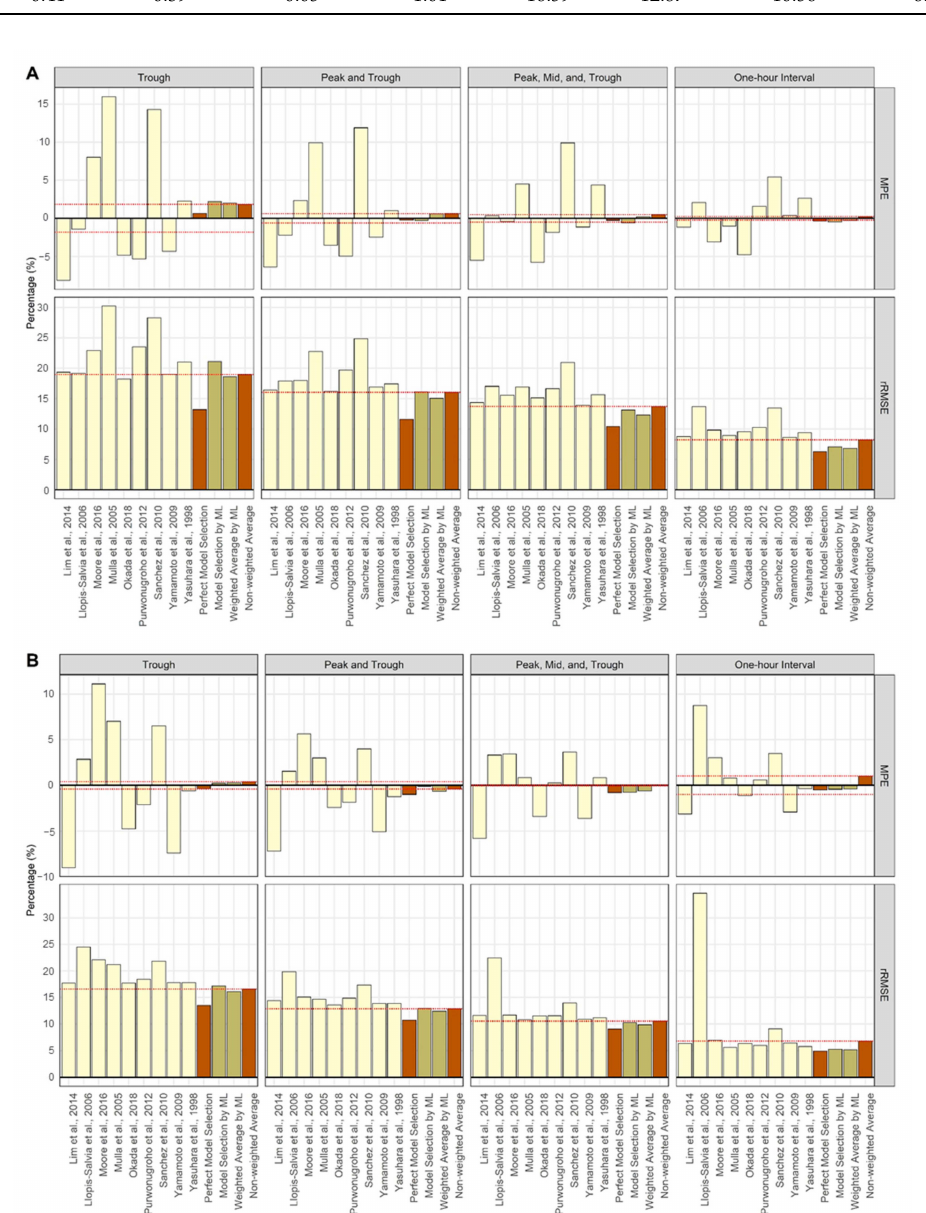
Figure 3. The mean percent error ( MPE ) and relative root mean squared error ( rRMSE ) of the predicted AUCs relative to the true AUCs of each simulation scenario for internal validation [19–27]. The prediction method (using a single model, ML application, and comparison) is distinguished by yellow, olive, and brown colors, respectively. The red dashed horizontal line is the value obtained using the non-weighted average method. ( A ) Single dose; ( B )